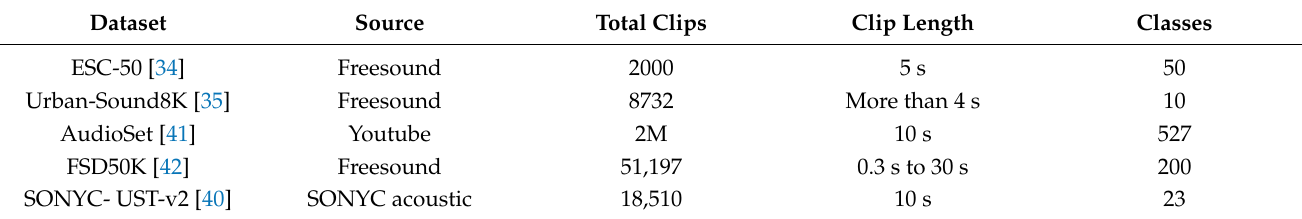
Figure 3. SONYC-UST-V2 dataset. Table 1. Summary of existing ESC